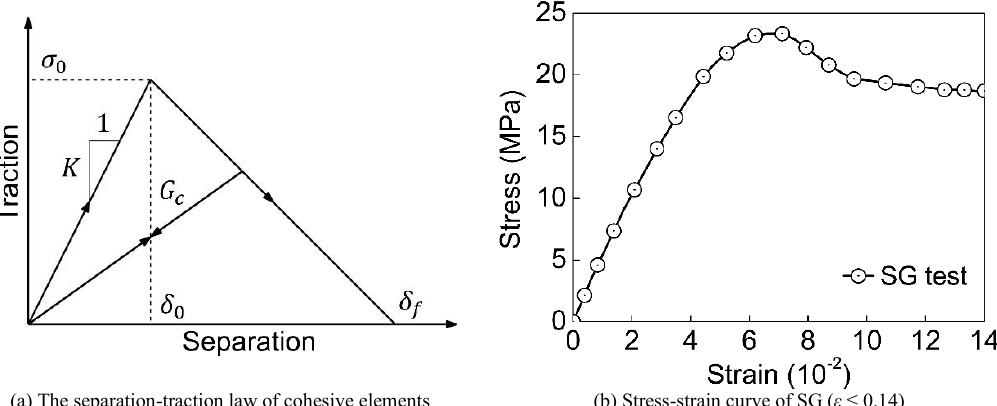
Fig. 5 Constitutive law used in the numerical